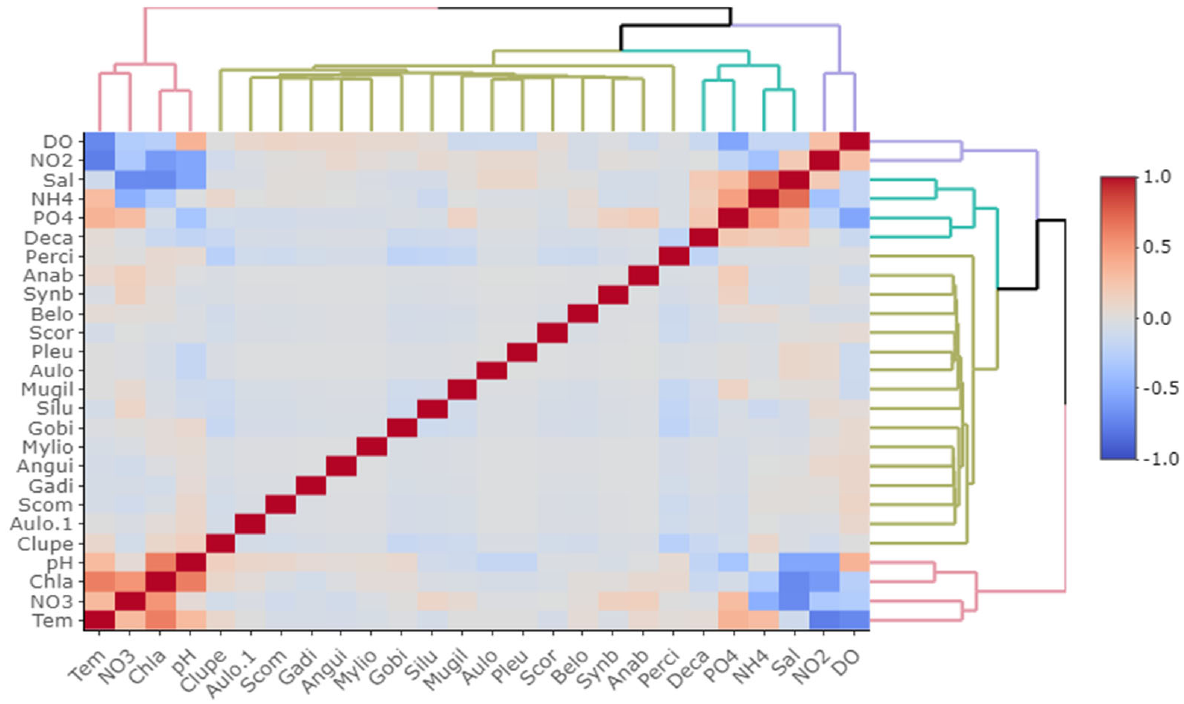
Figure 3. Dendrogram showing clustering of the water quality parameters and fish orders found in the MRE (Tem: Temperature, NO 3 − : Nitrate, Chla: Chlorophyll-a, Clupe: Clupeiformes, Aulo: Aulopiformes, Scom: Scombriformes, Gadi: Gadiformes, Angui: Anguiliformes, Mylio: Myliobati- formes, Gobi: Gobiiformes, Silu: Siluriformes, Mugil: Mugiliformes, Pleu: Pleuronectiformes, Scor: Scorpaeniformes, Belo: Beloniformes, Synb: Synbranchiformes, Anab: Anabantiformes, Perci: Per ‐ ciformes, Deca: Decapoda, PO 43_ : Phosphate, NH 4+ : Ammonia, Sal: Salinity, NO 2_ : Nitrite and DO: Dissolved oxygen).